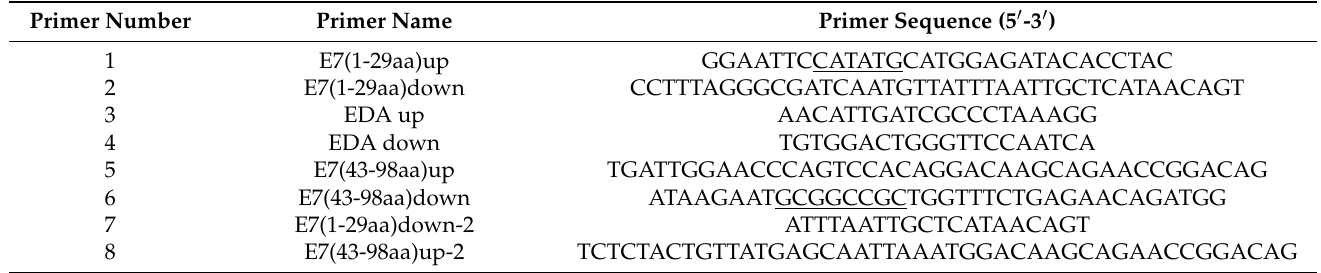
Table 1. Primers for over-lap PCR.